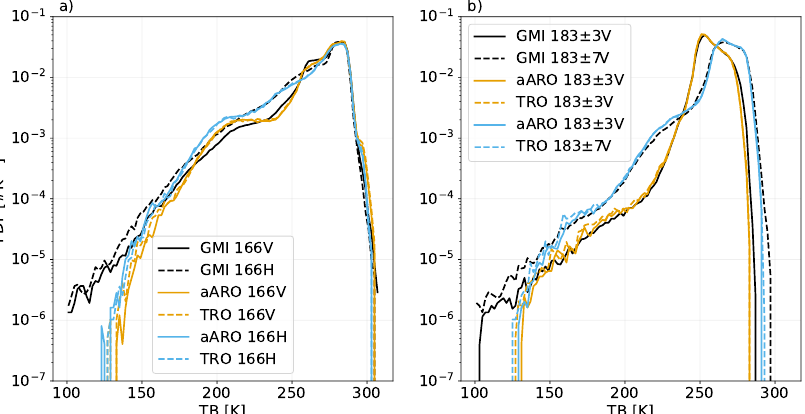
Figure A2. ( a , b ) The distribution of TBs for all high-frequency channels of GMI. The black curve represents the GMI measurements. The simulations were based on the Evans snow